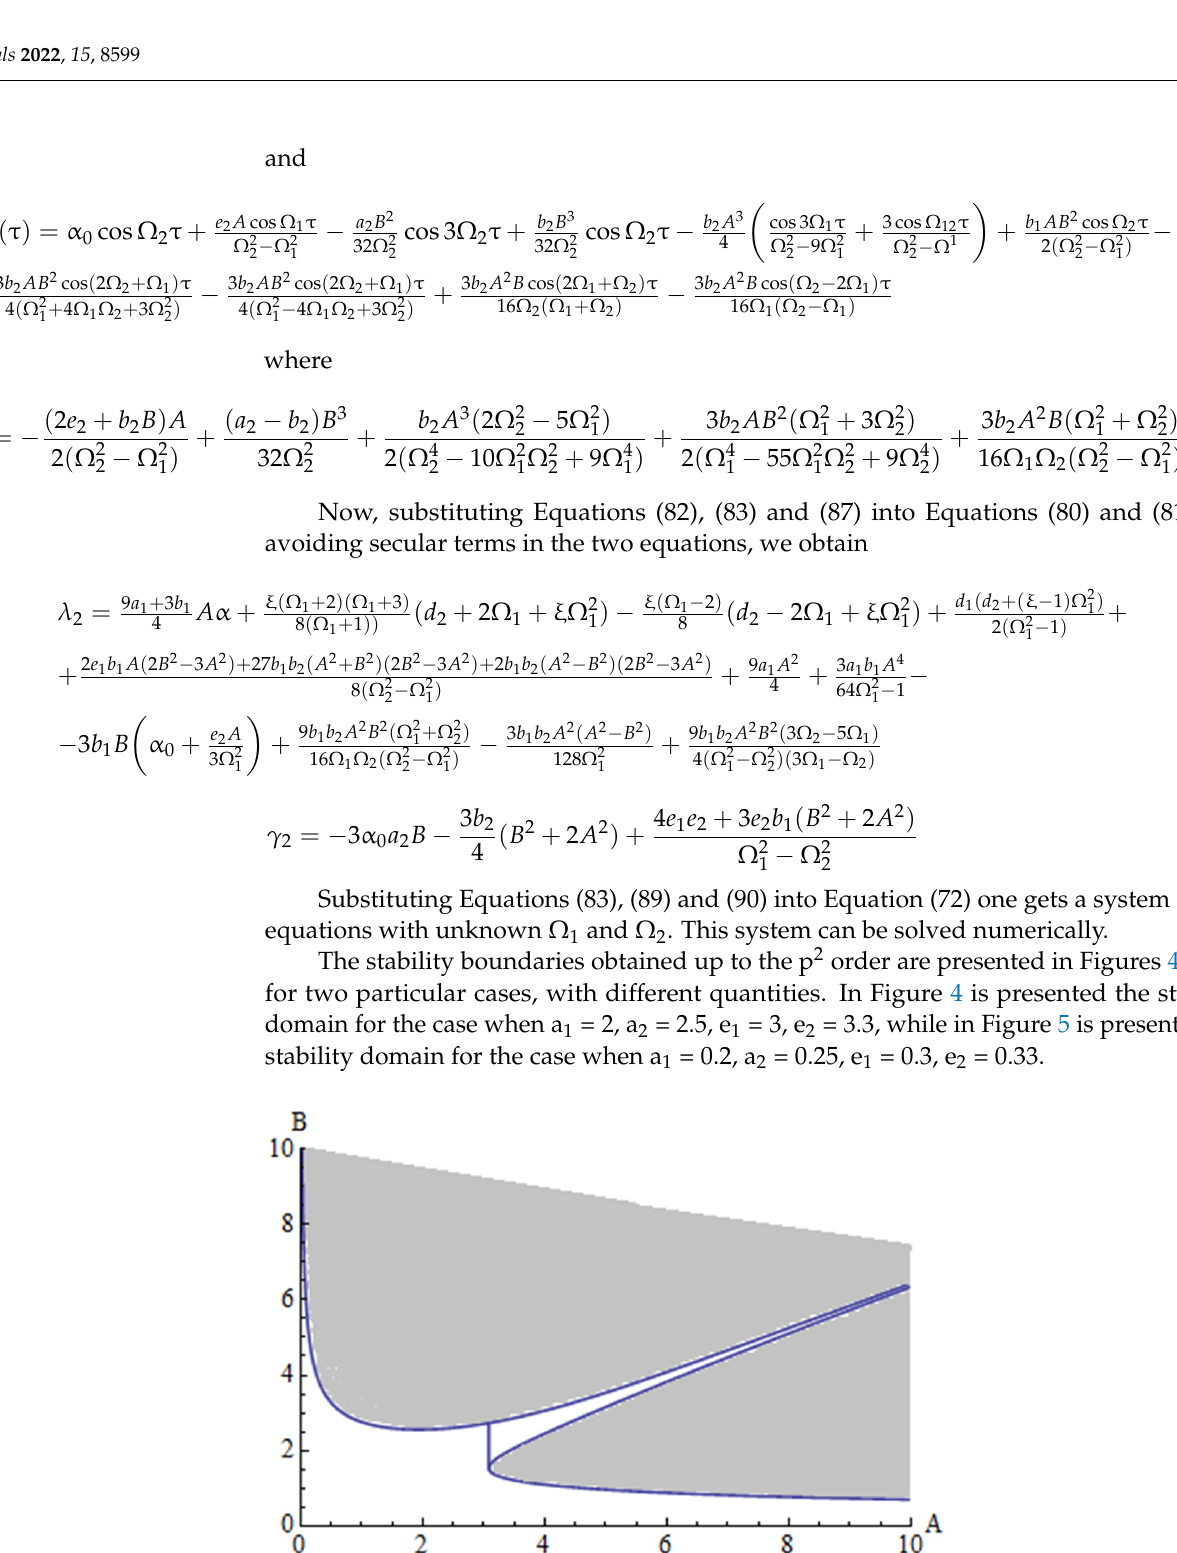
Figure 5. Stability domain for case 2 (shadow area): a 1 = 0.2, a 2 = 0.25, e 1 = 0.3, e 2 = 0.33. The boundary stability of the first tube is obtained from Equation (72). This boundary curve is 4 (cid:3398) 𝜆 (cid:2869) (cid:3398) 𝜆 (cid:2870) (cid:3404) 0 , where λ 1 and λ 2 are given by Equations (83) and (89). On the other hand, the boundary curve of the second tube can be obtained from 4 (cid:3398) 𝛾 (cid:2869) (cid:3398) 𝛾 (cid:2870) (cid:3404) 0 , where γ 1 and γ 2 are given by Equations (84) and (90). The area of stability for the first tube is given by 4 (cid:3398) 𝜆 (cid:2869) (cid:3398) 𝜆 (cid:2870) (cid:3408) 0 and for the second tube the area of stability is given by 4 (cid:3398) 𝛾 (cid:2869) (cid:3398) 𝛾 (cid:2870) (cid:3408) 0 . 7. Conclusions and Discussion After carrying out an analysis of nonlinear vibration of double-walled carbon nano- tubes subjected to mechanical impact, which is an important research direction in the field of new materials and has a large domain of applicability in engineering practice, the fol- lowing conclusions can be highlighted. •